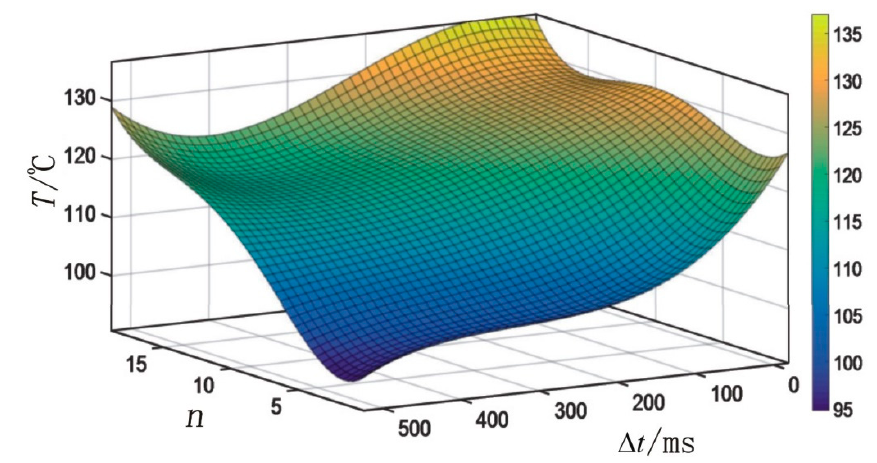
Figure 8. Average temperature rise of the ZnO varistor surface under three pulses.